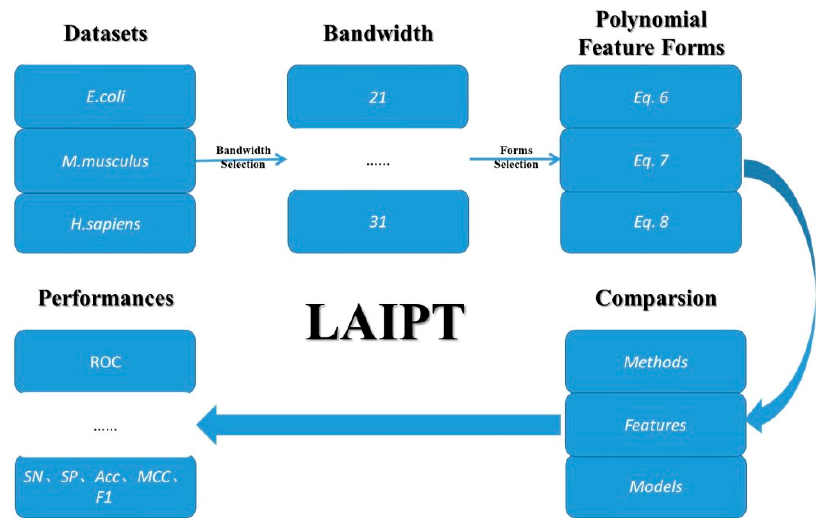
Figure 6. The outline of the lysine acetylation site identification with polynomial tree method (LAIPT).